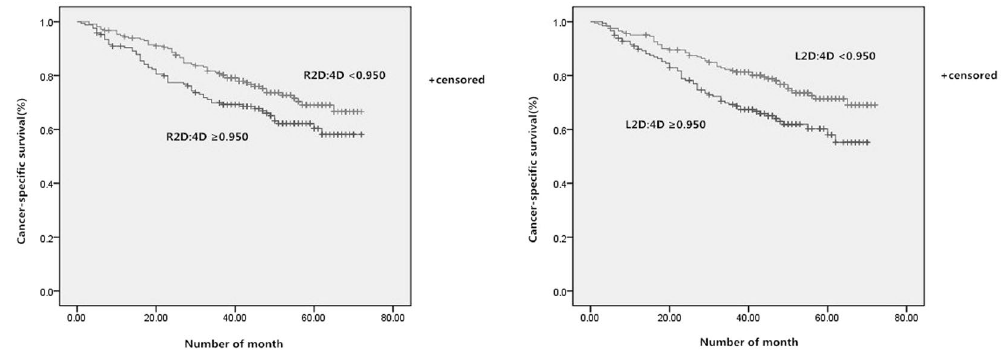
Figure 3. Kaplan–Meier curves for cancer specific survival, according to the R2D:4D and L2D:4D ( < 0.950 versus ≥